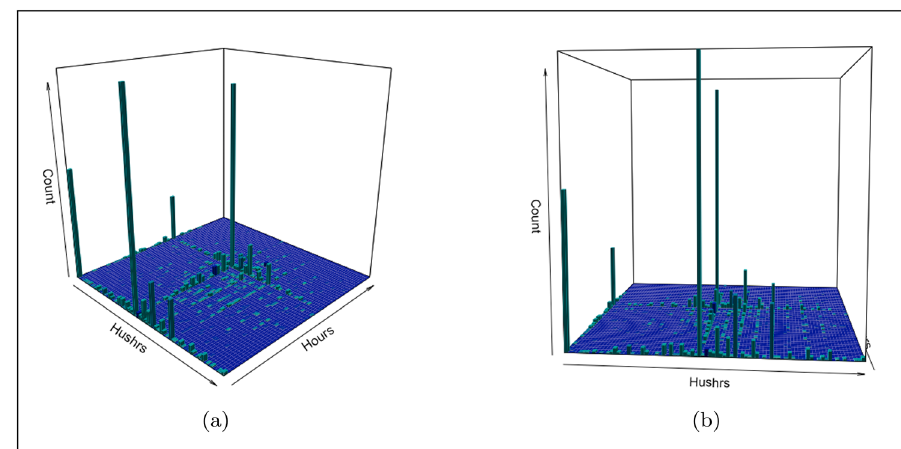
Figure 4: Histogram of hushrs and hours variables from the cps91 data